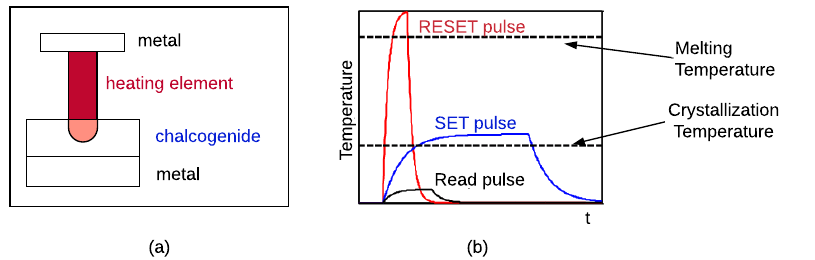
Figure 2. ( a ) A phase change memory (PCM) cell and ( b ) temperature needed to SET, RESET, and